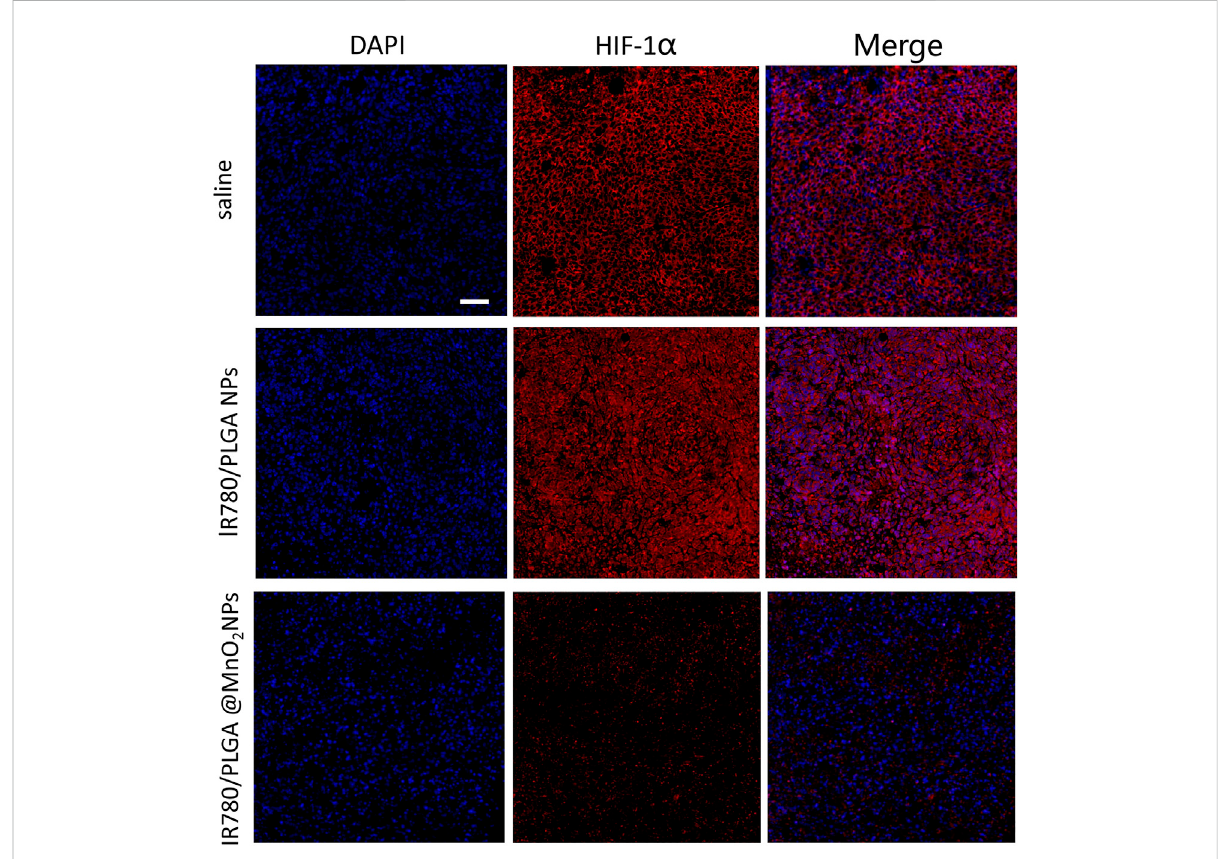
FIGURE 8 Representative immuno fl uorescence images of tumor slices stained by the HIF-1 α under different treatments (scale bar, 200 µm).